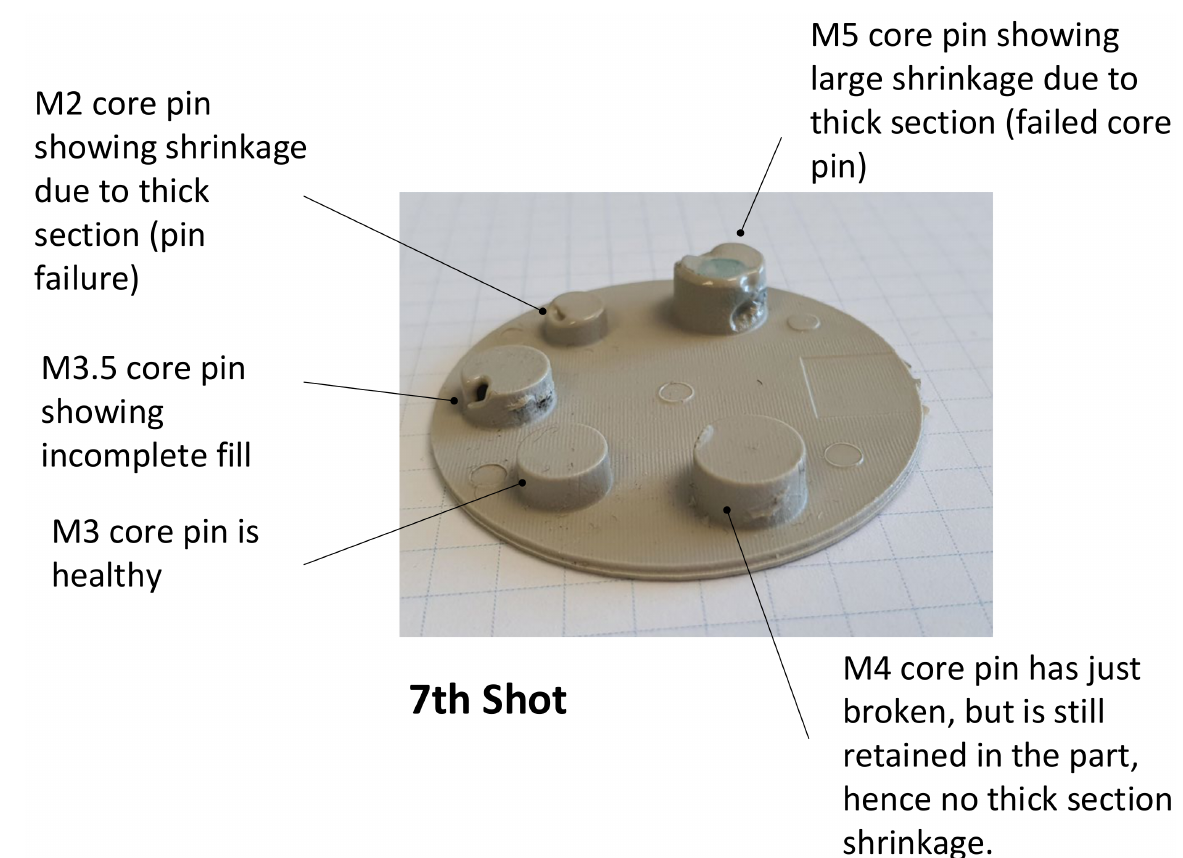
Figure 23. Part 7, showing a number of different defects on the cavity